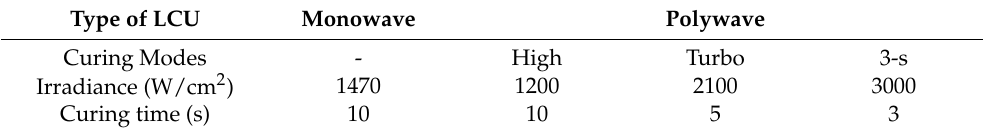
Table 1. Different types of LCU and curing modes with their respective irradiance and curing modes.